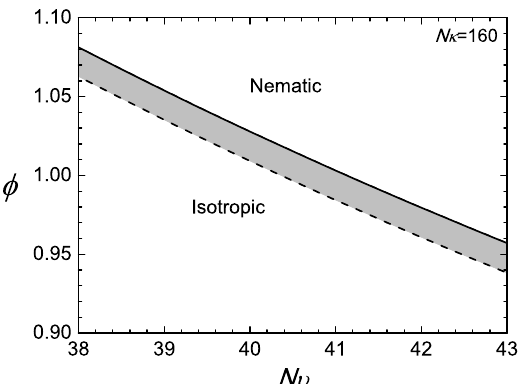
Figure 2. Example of a phase diagram for a compressible system with N κ = 160. The phase space is divided into two regimes: nematic above the nematic volume fraction φ N represented by the solid line; and isotropic below the isotropic volume fraction φ I represented by the dotted line.